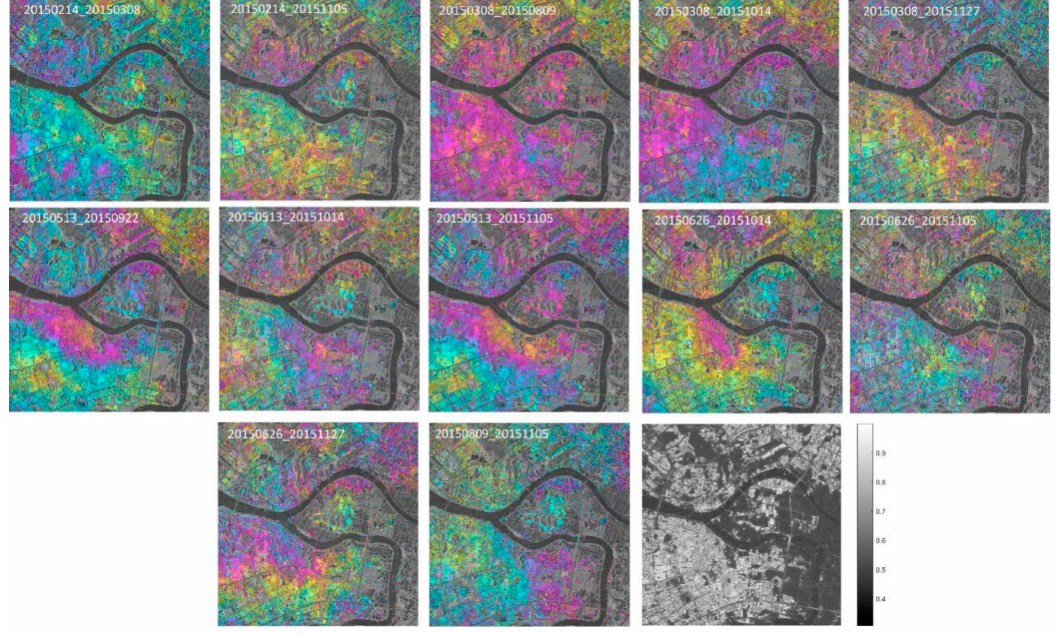
Figure 6. Selected interferometric images and the average coherence map (the last picture, bottom right) of the area shown in Figure